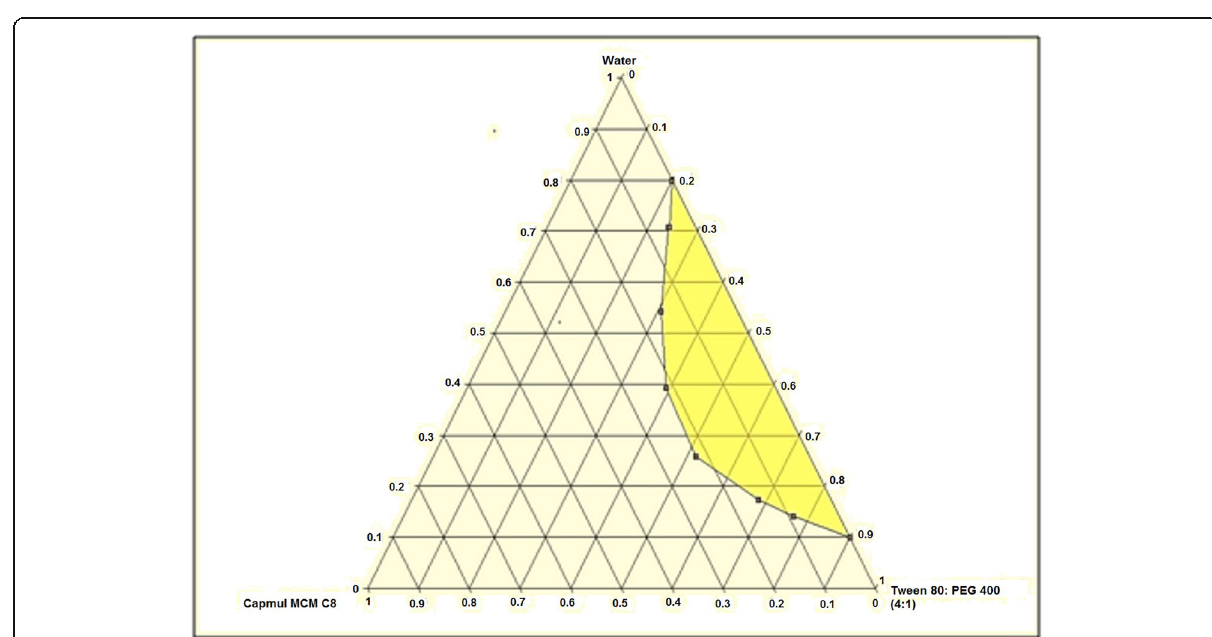
Fig. 1 Pseudoternary phase diagram showing microemulsion region containing S:CoS ratio of 4:1